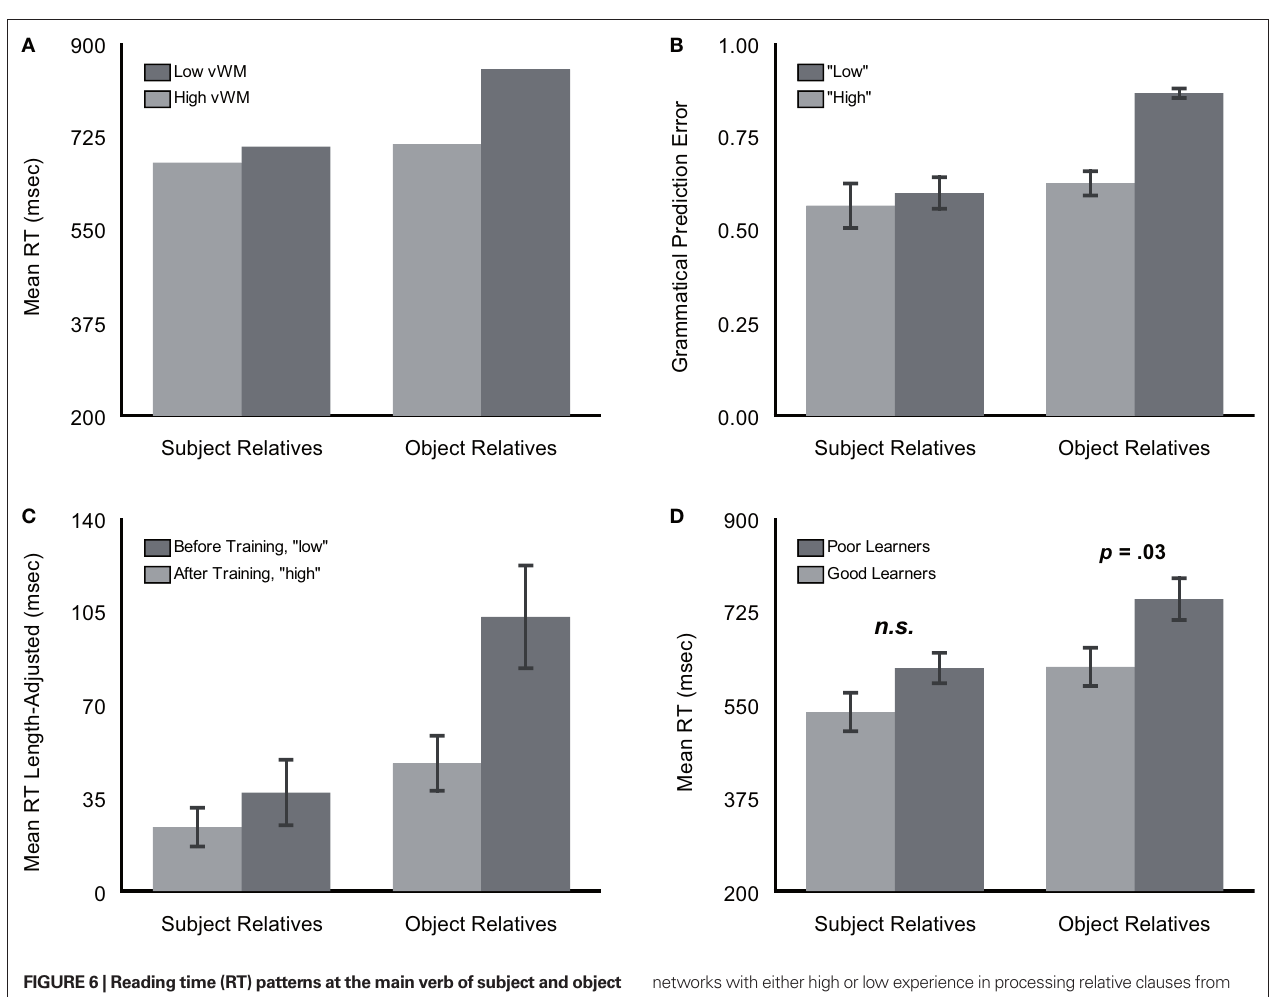
Figure 6 | reading time (rT) patterns at the main verb of subject and object relative clauses from four related studies. (A) Individuals measured to have high and low verbal working memory (vWM) in King and Just’s (1991) study [means are estimates obtained from Figure 2, p. 130, of Just and Carpenter’s presentation (1992) of the King and Just (1991) data]; (B) simulated RT patterns of